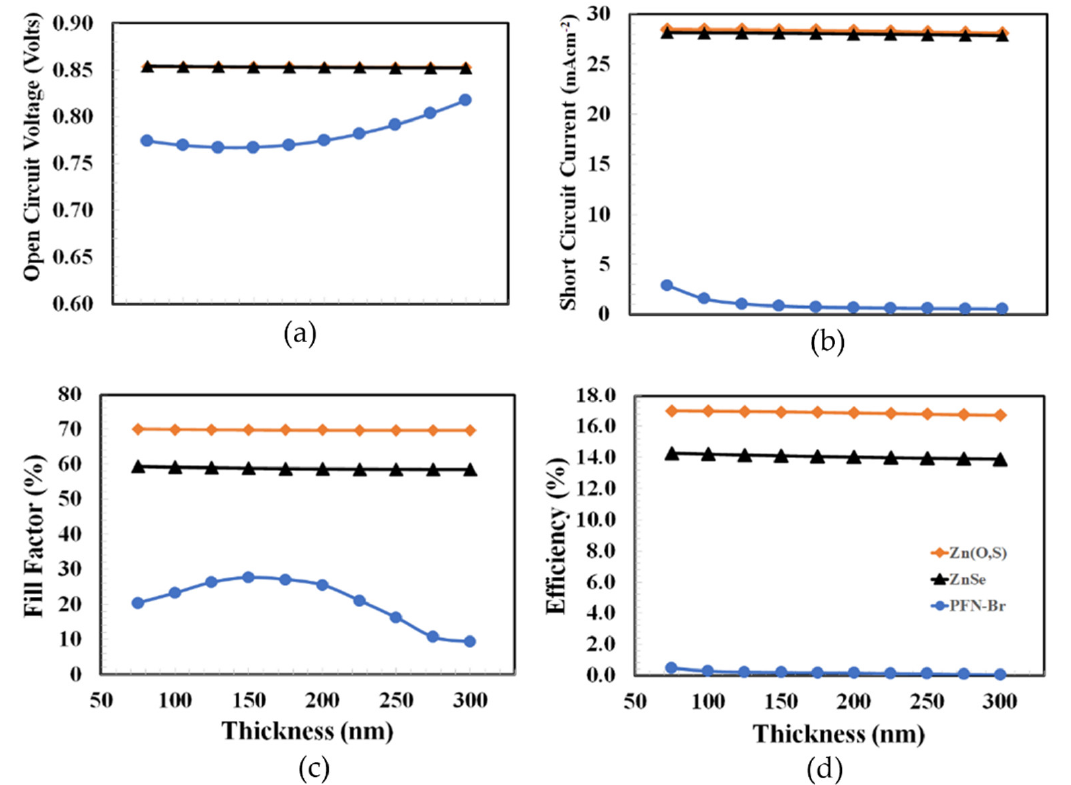
Figure 5. The photovoltaic parameters of ( a ) open-circuit voltage, ( b ) short-circuit current, ( c ) fill factor, and ( d ) power conversion efficiency as a function of electron transport layer (Zn(O,S), ZnSe, PFN-Br) thickness for TO/Zn(O,S)/PTB7:PC 70 BM/PEDOT:PSS/Au, ITO/ZnSe/PTB7:PC 70 BM/PEDOT:PSS/Au, ITO/PFN-Br/PTB7:PC 70 BM/PEDOT:PSS/Au, respectively.